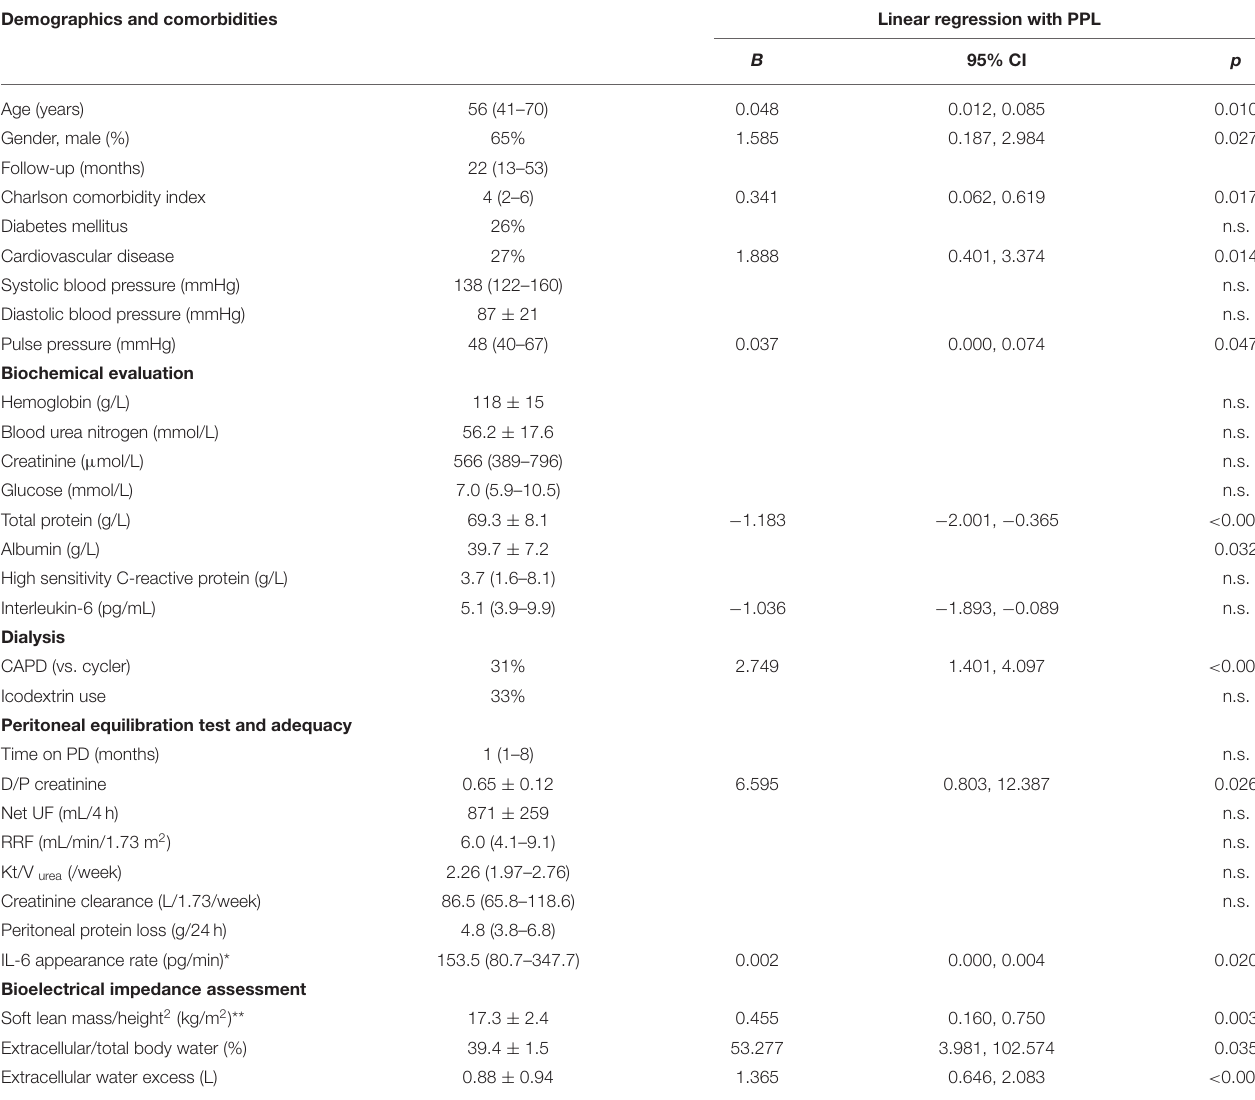
TABLE 1 | Characterization of the patient population ( n = 78 patients) and linear univariable regression with peritoneal protein loss. Demographics and